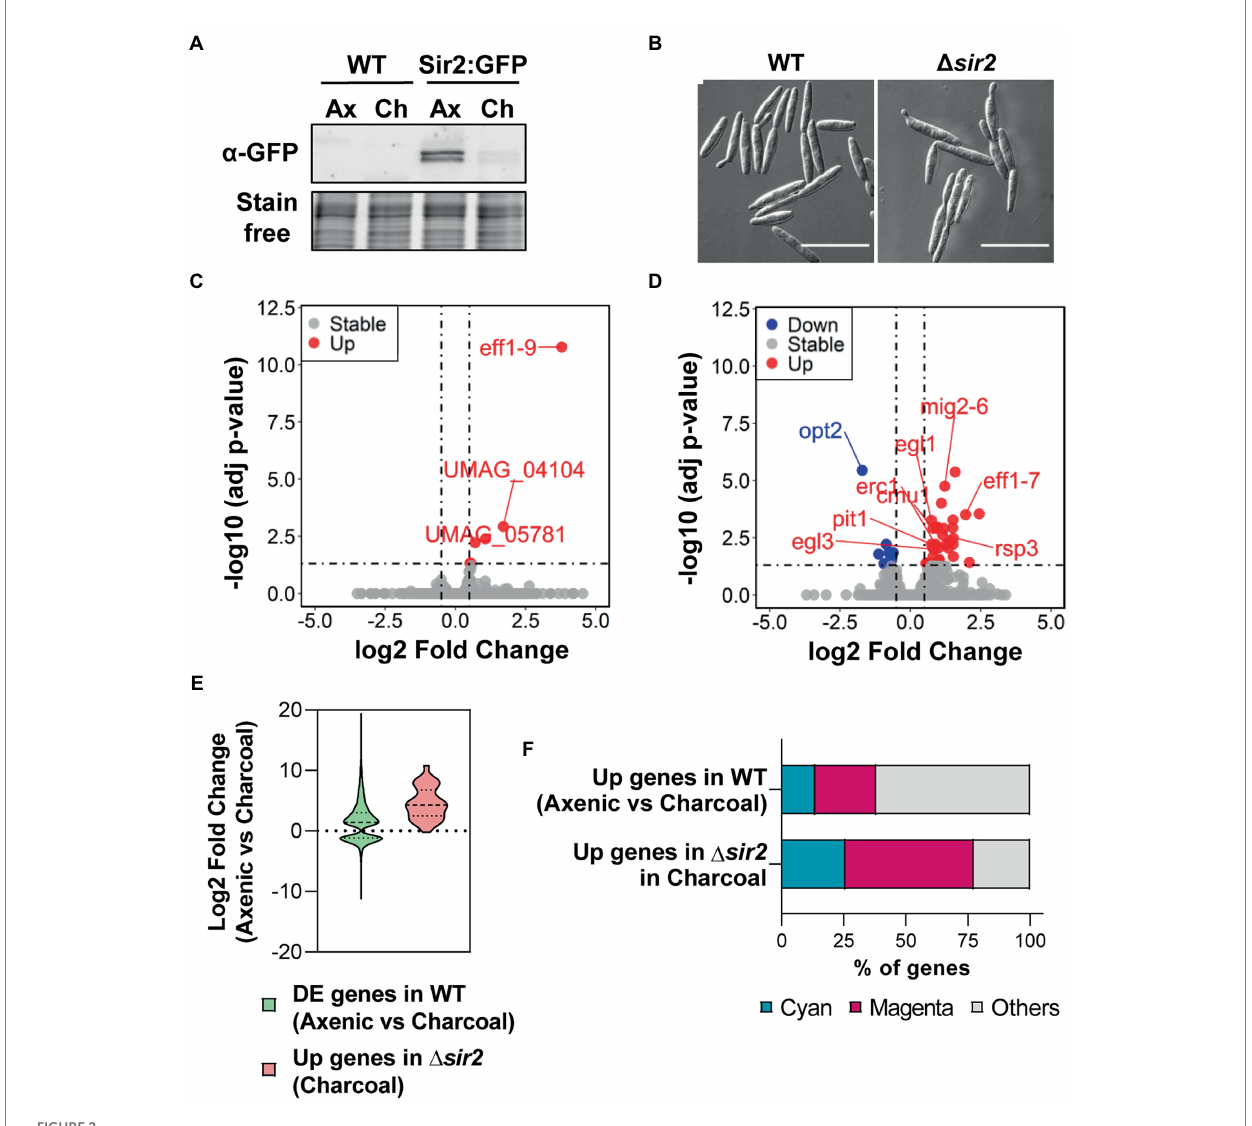
FIGURE 2 Sir2 is degraded during filamentation and is involved in the repression of a group of filamentation-induced genes. (A) Western blot showing Sir2:eGFP protein levels of wild-type strain. Total proteins were extracted from cells growing in axenic culture (Ax) and PD–charcoal plates (Ch) for 18 h at 25 ° C. Stain-free gel is shown as a loading control. (B) Images of wild-type and Δ sir2 mutant growing in axenic culture. Scale bar represents 20 μ m. (C,D) Volcano plot showing the log2 fold change in gene expression and the statistical significance of the differential expression analysis from RNA-seq data obtained for the Δ sir2 mutant compared to wild-type in axenic culture (C) and PD–charcoal plates (D) . Red, blue and grey dots represent the upregulated genes (log2 fold change ≥ 0.5, adjusted p -value < 0.05), downregulated genes (log2 fold change ≤ − 0.5 adjusted p -value < 0.05) and genes without changes in the Δ sir2 mutant, respectively. sir2 data has been removed for plotting purpose. (E) Log2 fold change distribution of the differentially expressed genes (adjusted p -value < 0.05) for wild-type in PD–charcoal plates compared to axenic culture and for the upregulated genes in the Δ sir2 mutant compared to wild-type in PD–charcoal plates. (F) Percentage of genes belonging to the magenta (genes induced during the establishment and maintenance of biotrophism) or cyan modules (genes induced during tumor formation) of coexpressed genes throughout infection for the upregulated genes of wild-type in PD–charcoal plates compared to axenic culture and for the upregulated genes in the Δ sir2 mutant compared to wild-type in PD–charcoal